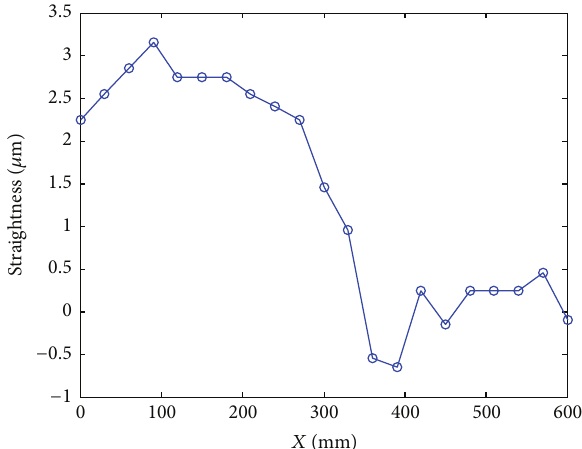
Figure 6: Measurement and fitting curve of straightness.